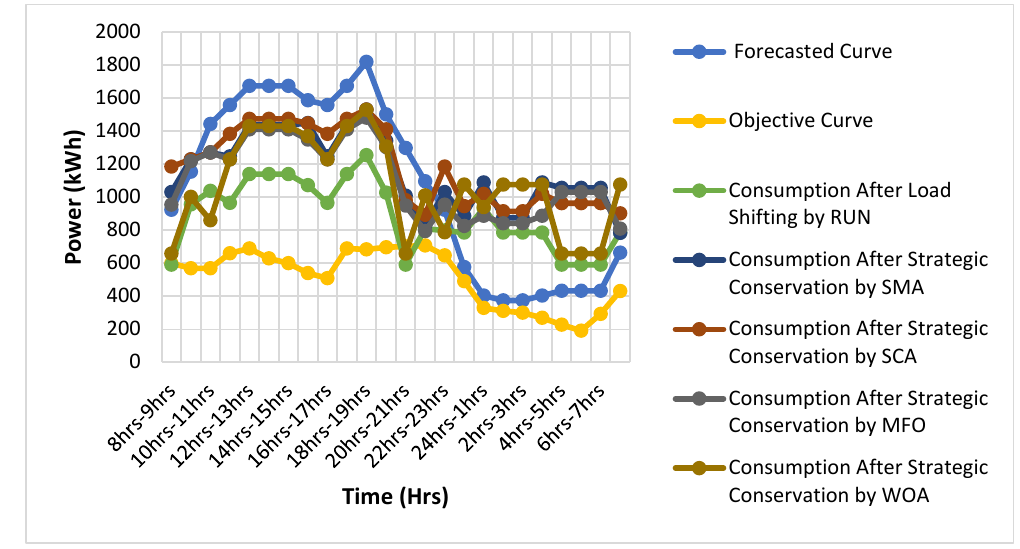
Figure 12. Load shifting results for commercial consumers. Table 5. Operational cost and peak demand reduction due to load shifting. ???? show the peak reduction and operational cost, respectively, for load shifting.